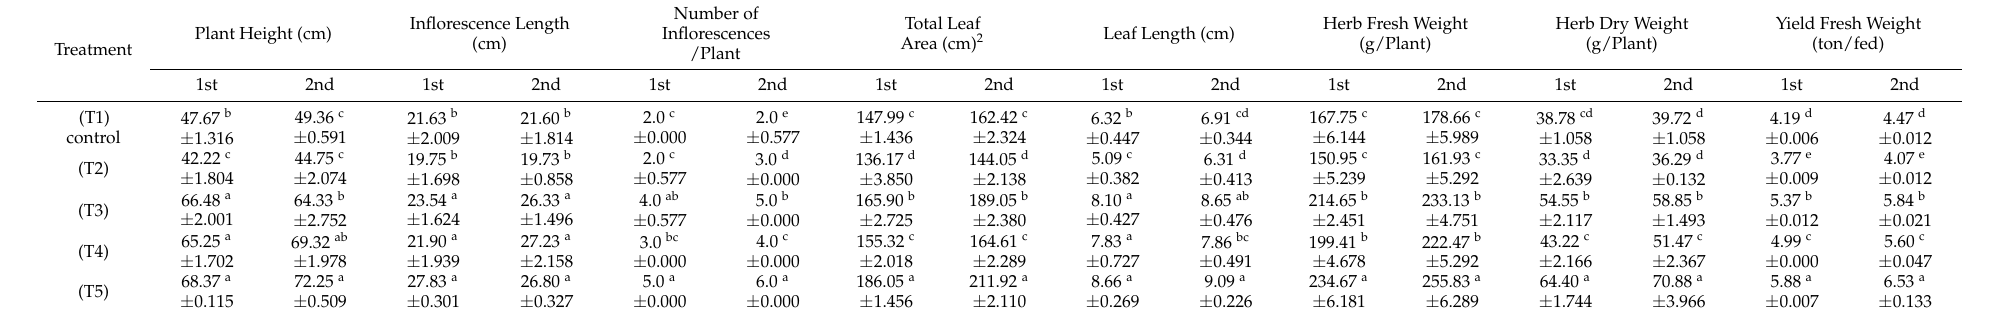
Table 4. Growth and yield characteristics under drought conditions and different nanoparticle applications on Solidago canadensis plants during the 2020 and 2021 growing seasons.